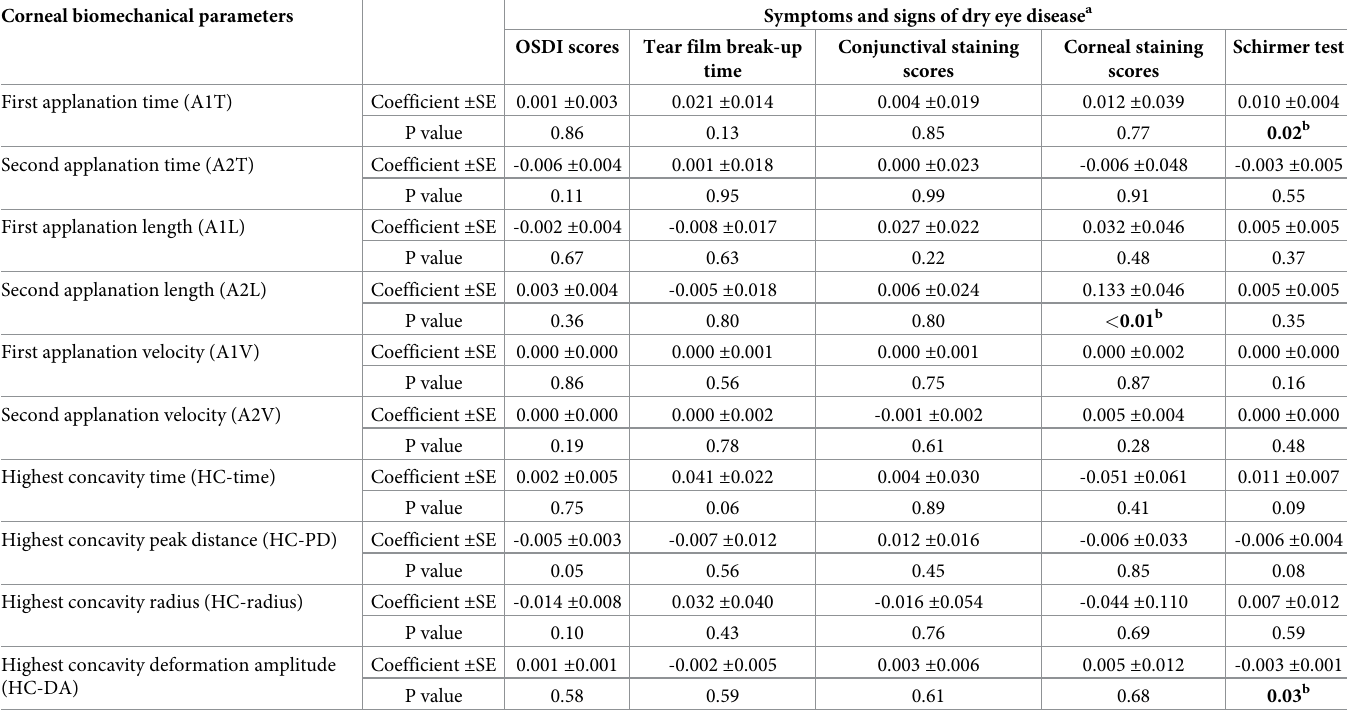
Table 5. The associations between symptoms and signs of dry eye disease and corneal biomechanical parameters in the normal tear production group. Corneal biomechanical